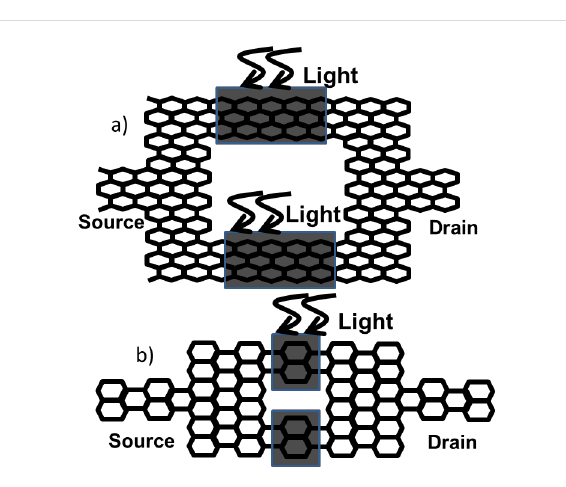
Figure 4: Device structure for light detection by coupling light between two resonant peaks. (top) zigzag structure (bottom) armchair structure.